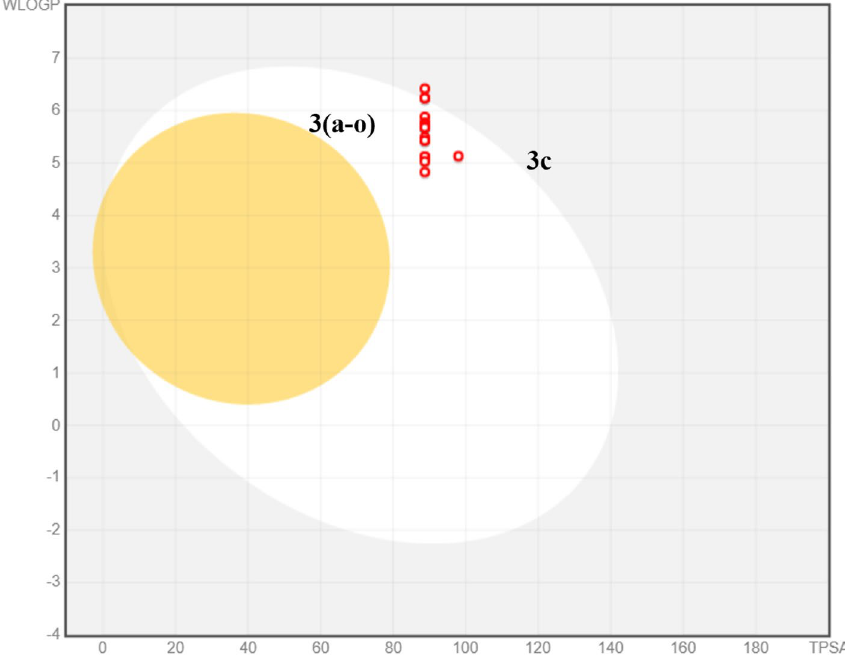
Figure 7. Boiled-egg plot for substituted-thiosemicarbazones for ADME